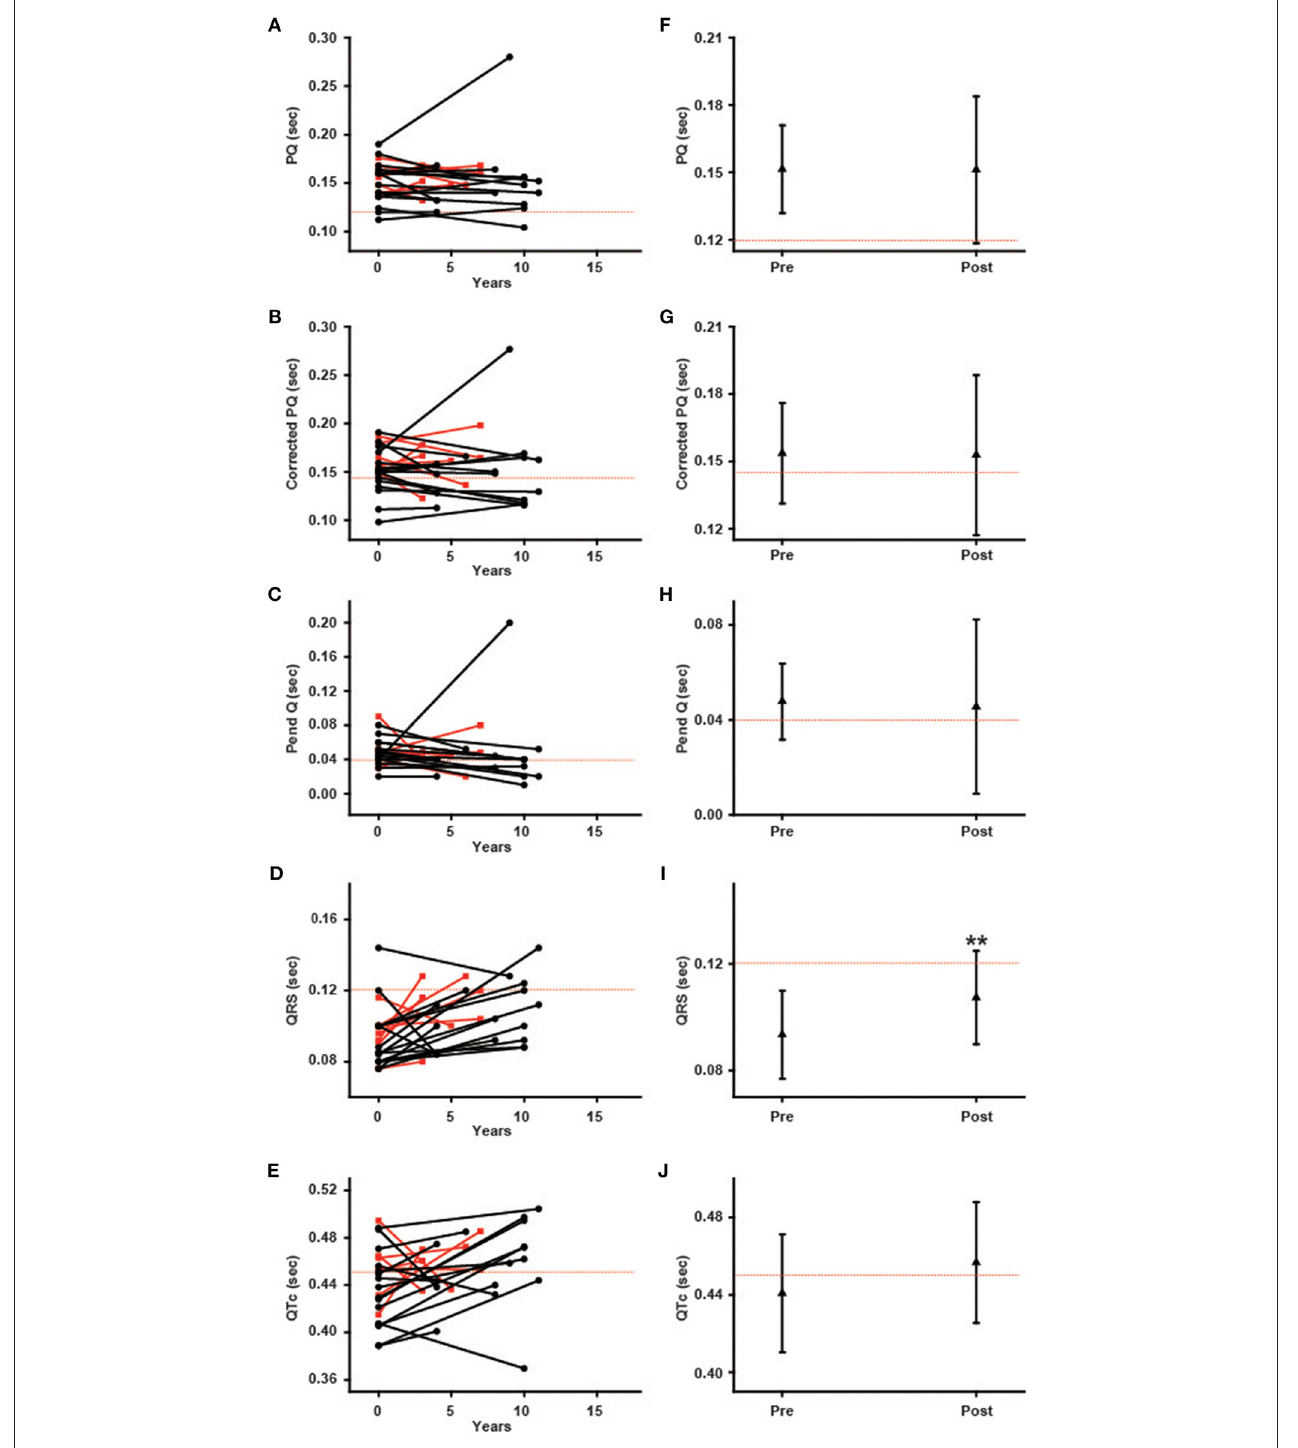
FIGURE 4 | Changes in various ECG parameters during long-term enzyme replacement therapy in female patients. In the left columns, each line indicates the time-dependent changes in ECG parameters in each patient (A–E) . The black lines show the patients with the classical type, and the red lines show the patients with the late-onset type. The right columns show the average values of ECG parameters before (Pre) and after (Post) long-term enzyme replacement therapy (F–J) . The dotted lines indicate the cut-off value for abnormalities in each parameter. Corrected PQ, PQ interval divided by the square root of RR interval; Pend-Q, PQ interval minus P-wave duration in lead II; QTc, QT interval divided by the square root of RR interval. ** p < 0.01 comparison between before (Pre) and after (Post) enzyme replacement therapy.